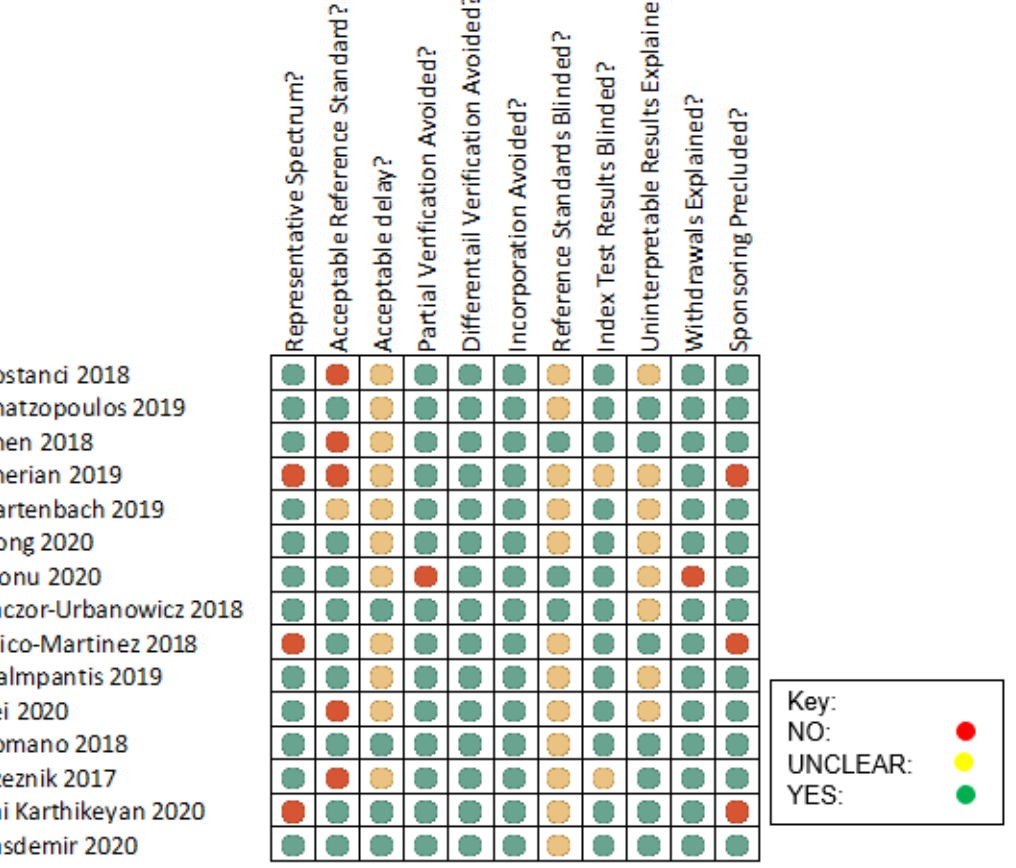
Figure 2. Assessment of quality and risk of bias of cross-sectional studies included in this systematic review. Table 2. Base-line characteristics of studies focusing on the detection of RNA biomarkers in oral biofluids. m , Male; f , Female; H , Periodontally Healthy; CP , Chronic Periodontitis; P1 , Discovery Phase; G , Gingivitis; P2 , Validation Phase; exRNA , Extracellular RNA; miRNA , MicroRNA; GCF , Gingival Crevicular Fluid.